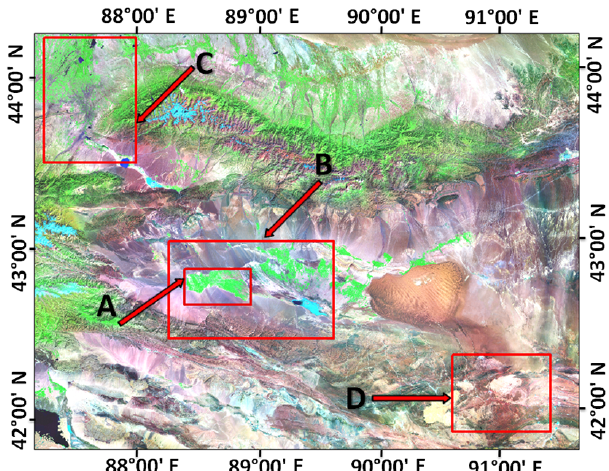
Figure 3. Selected areas for the examination of the spatial seasonal variation in the tropospheric NO 2 VCDs: rectangles “A”, “B”, “C”, and “D” represent an agricultural area (Tohsun), a mixed land use area (Tohsun and Turpan), a large urban area (Urumqi), and a desert area,